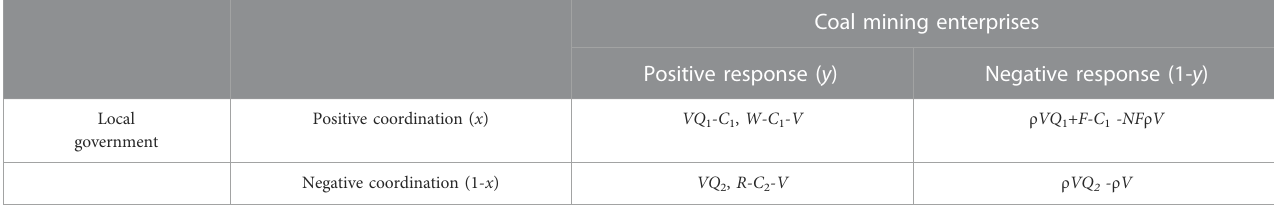
TABLE 1 Revenue matrix of emergency cooperative game model between local government and coal mining enterprises.